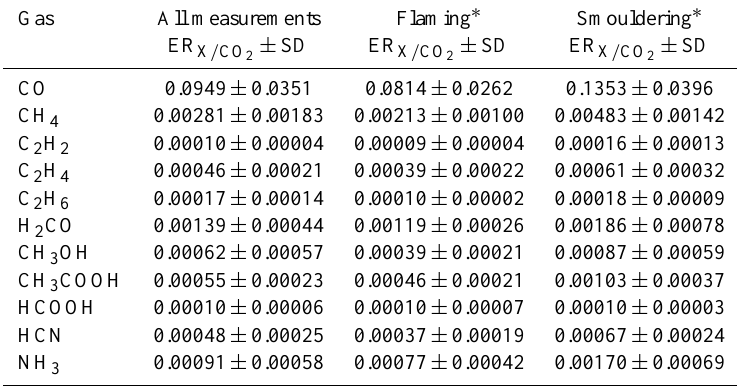
) calculated from OP-FTIR measurements at 21 tropical Table 2. Mean emission ratios for compound X with respect to CO 2 (ER X / CO 2 savanna fires over the three campaigns to the Northern Territory. The standard deviation of the emission ratios is also included. Gas All measurements